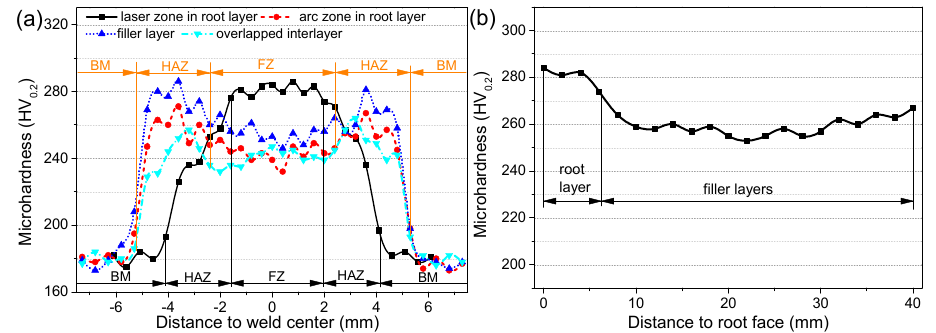
Figure 8. Microhardness profiles across weld surface, ( a ) profiles along horizon direction of different layers; ( b ) profile along thickness direction of weld center.